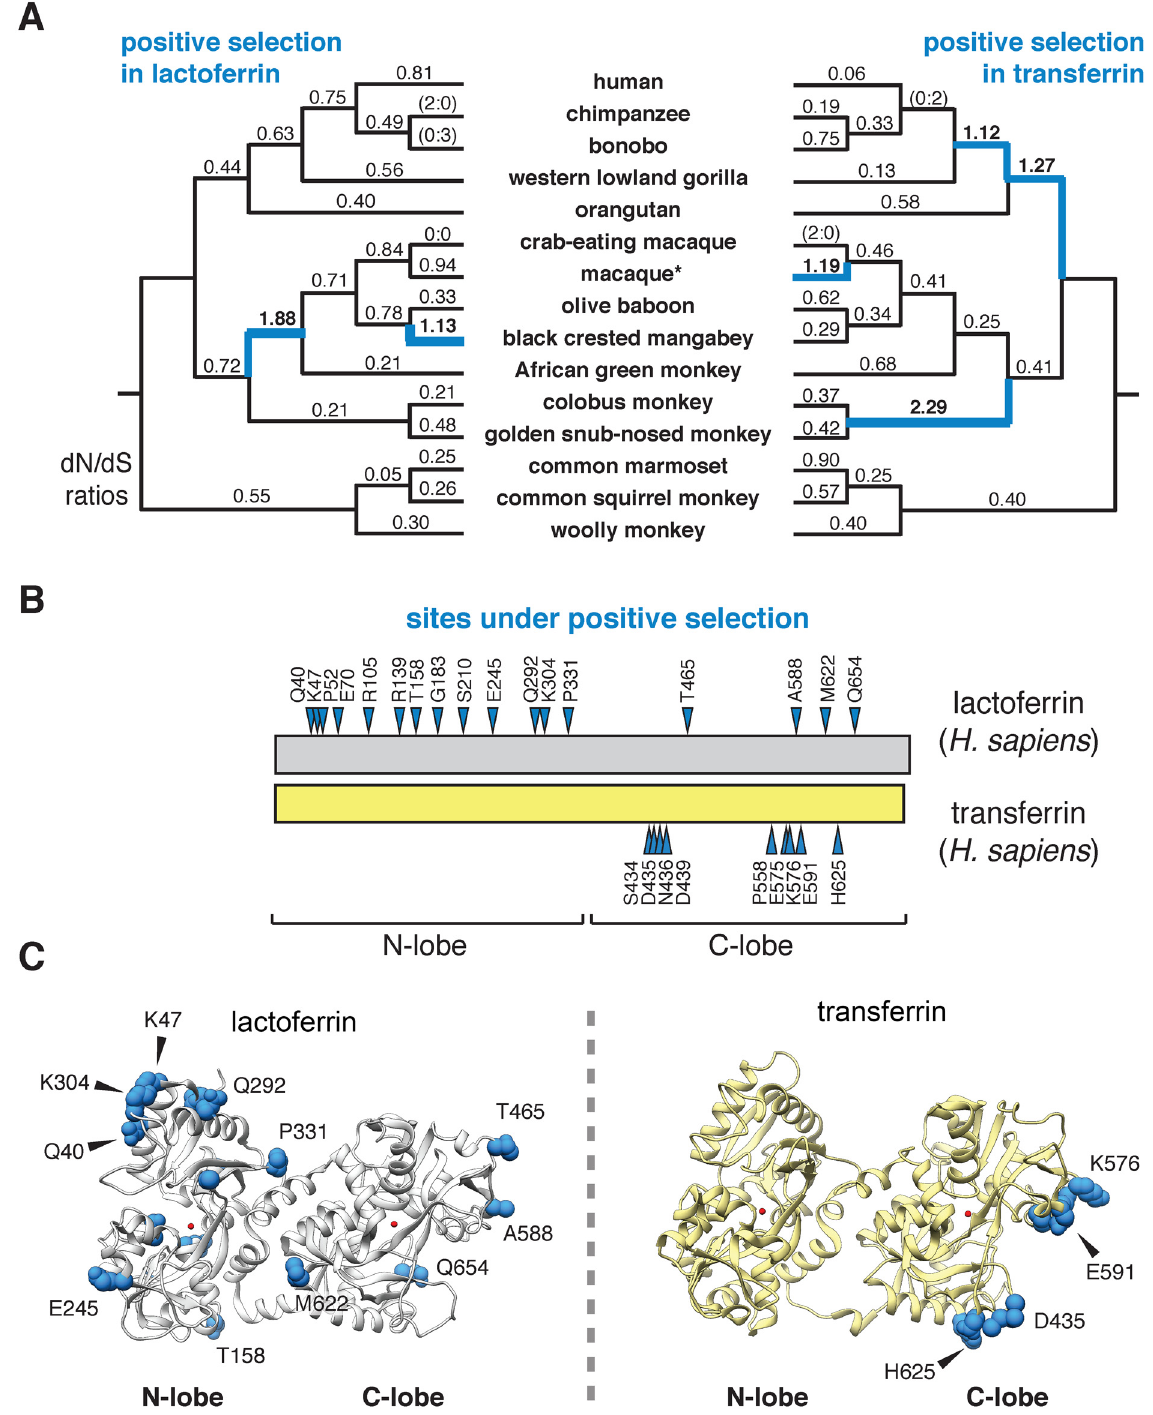
Fig 1. Dynamic evolution of the lactoferrin N lobe in primates. A. Paired primate phylograms showing signatures of positive selection in lactoferrin and transferrin. d N/ d S ratios along each lineage are shown, with ratios greater than 1 (indicative of positive selection) shown in blue. Branches with no silent or nonsynonymous mutations display ratios in parentheses. * For lactoferrin analyses the sequence of the Taiwanese macaque was used, whereas for transferrin rhesus macaque was included. This difference does not change the topology of the primate phylogram. B. Sites subject to positive selection in lactoferrin and transferrin are shown (blue arrows) along a schematic of the two proteins (phylogenetic analysis by maximum likelihood, posterior probability